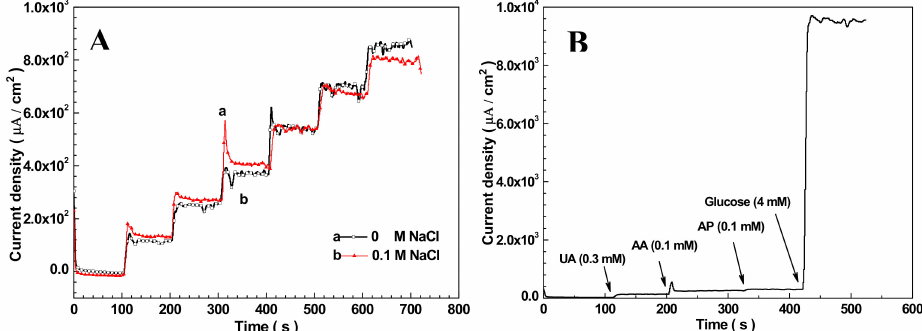
Figure 5. ( A ) Chroamperometric response of Nafion / Cu 2 O–BSA / GCE to glucose in 0 M (a) and 0.1 M (b) chloride ions; ( B ) Interference test of Nafion / Cu 2 O–BSA / GCE to 0.3 mM UA, 0.1 mM AA and 0.1 mM AP in 50 m NaOH at 0.6